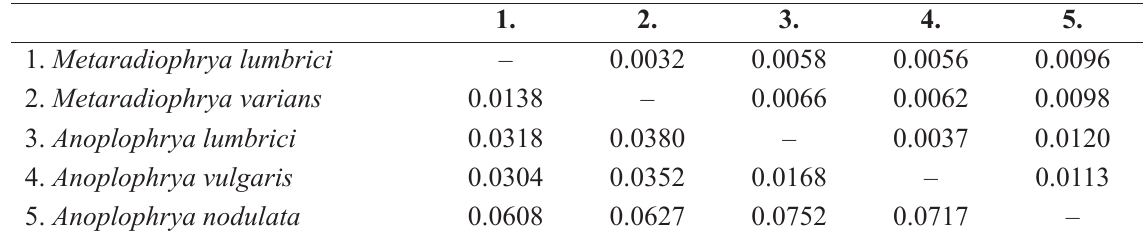
Table 5. Average between group evolutionary distances (below diagonal) and their standard errors (above diagonal) estimated with the maximum composite likelihood